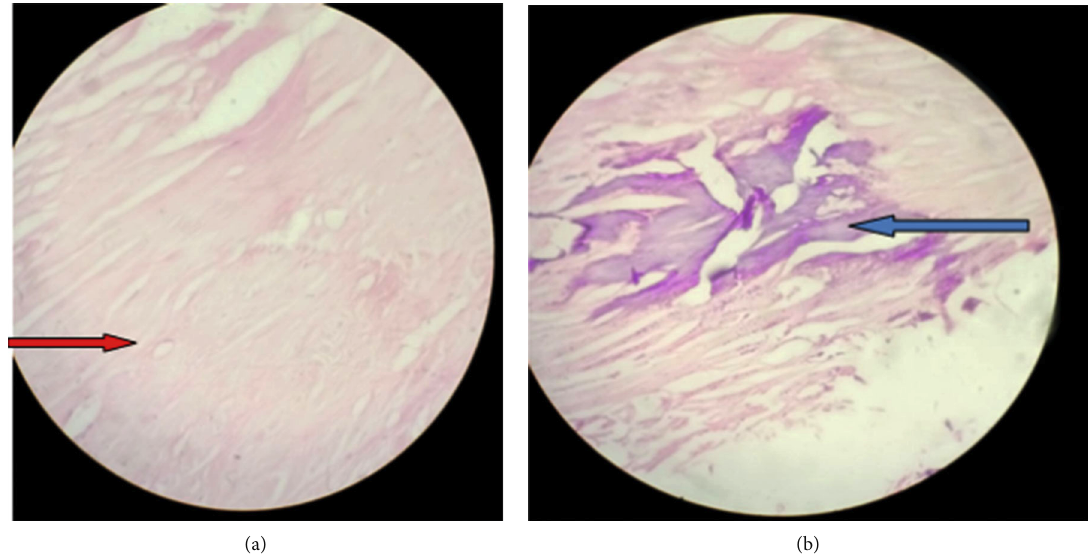
Figure 6: (a, b) High-power photomicrograph revealing an acellular fi brotic cyst wall (red arrow) and focus of calci fi ed cyst wall (blue